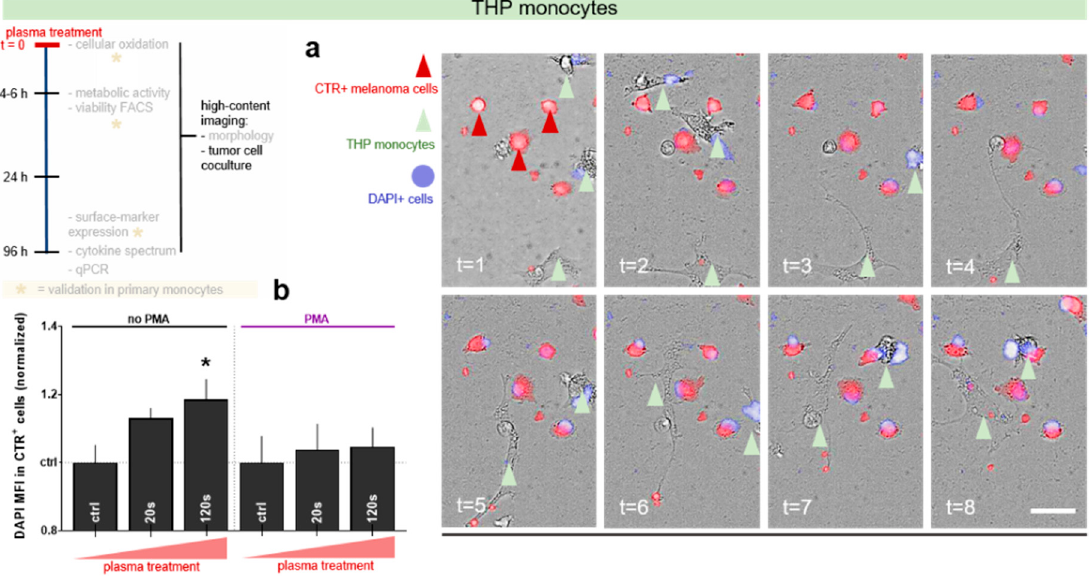
Figure 6. Co-culture of plasma-stimulated THP-1 monocytes with human A375 melanoma cells. ( a ) The representative images of the time course of co-culture with 120 s plasma-treated THP-1 cells up to 8 h indicated by t, green arrows point to myeloid cells, red arrows in t = 1 to melanoma cells; ( b ) The quantification of DAPI as dead-cell dye in cell trace red (CTR) labeled melanoma cells at 8 h after initiation of co-culture. ( b ) The quantification of DAPI uptake in melanoma cells in untreated, or 20 s or 120 s plasma-treated conditions ( ± PMA). The data are the mean + SD from two independent experiments with three technical replicates each. The statistical analysis was performed using one-way anova with Dunnett post-testing to respective controls. The seconds (s) indicate plasma treatment time, ctrl = control, scale bar = 50 µ